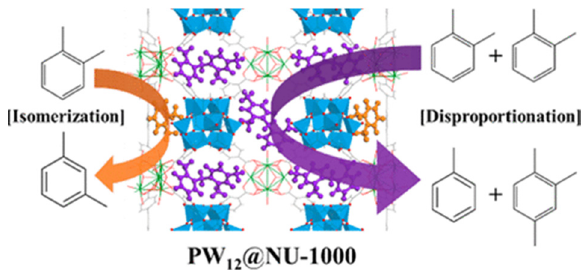
Figure 11. Phosphotungstic acid encapsulated in NU-1000 for its use in the aggressive hydrocarbon isomerization reaction. Reprinted with permission from [133]. Copyright (2018), American Chemistry Society.